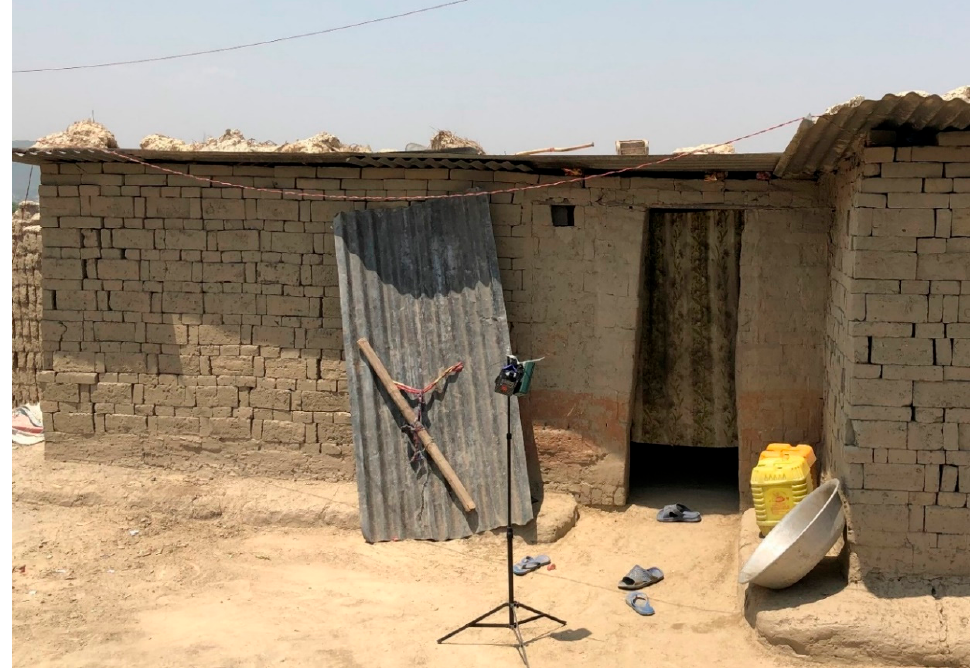
Figure 1. Typical construction of brick workers’ homes sampled in this study. Construction consisted of dirt floors and un-mortared brick walls. Tin roofs were constructed by placing bamboo or wooden poles across the top of the walls, with sheet metal placed on the poles. Rocks, bricks, soil, and other heavy objects were used to hold the sheet metal in place. Indoor samples were collected by attaching PM 2.5 and temperature/relative humidity instruments to tripods as shown. Tripods with the attached instruments were placed inside the home during the entire sampling period. Abbreviation: PM 2.5 , particulate matter with an aerodynamic diameter less than 2.5 μ m.